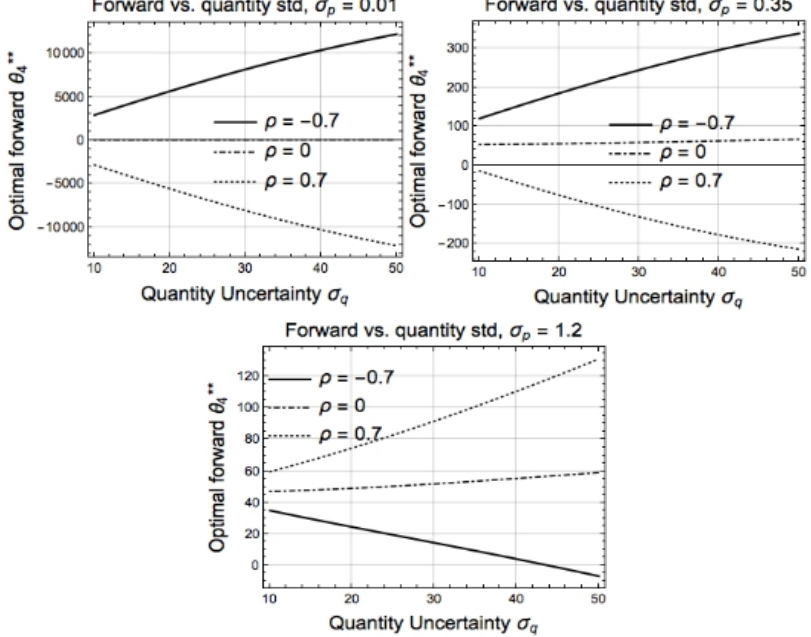
Figure 8. Comparison of θ ∗∗ as from Theorem 4 as a function of quantity volatility σ q under small (top-left, σ p = 0.01 ), medium (middle, σ p = 0.35 ), and large (right, σ p = 1.2 ) price volatility. In each plot, the three correlation conditions ( ρ = − 0.7, ρ = 0, = 0.7 ) are also described.